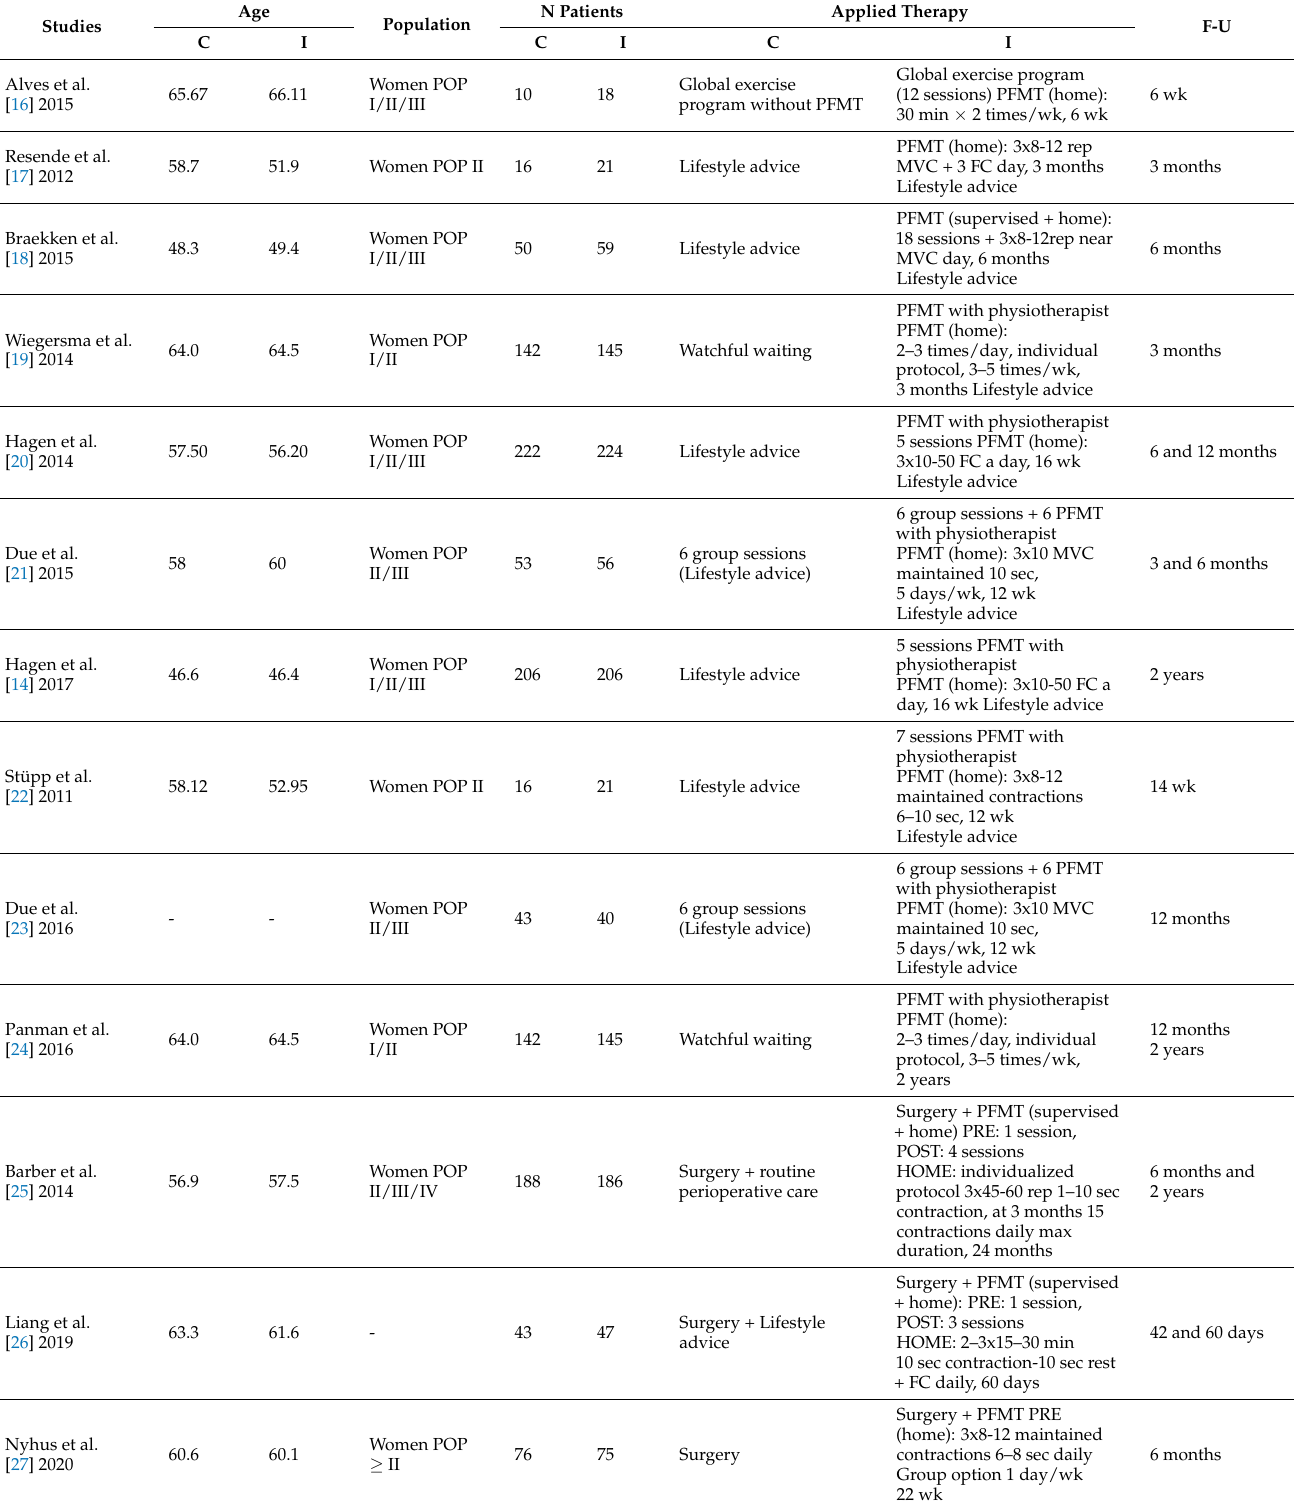
Table 2. Summary of selected